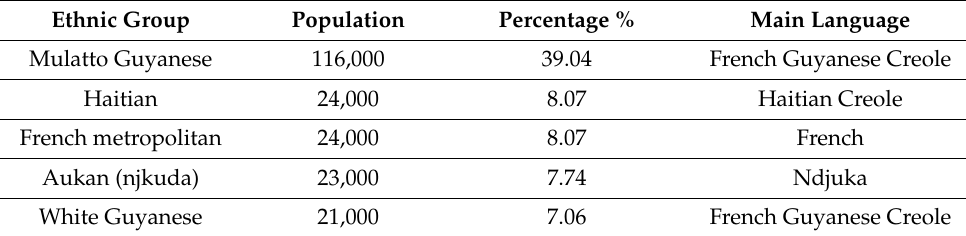
Table 2. Ethnocultural groups in Guiana (Source: Joshua Project). Ethnic Group Population Percentage % Main Language Mulatto Guyanese 116,000